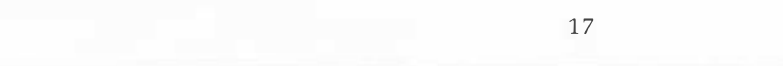
Figure 2 Culverwell mesolithic site: schematic stratigraphic section of the east-facing side of trench 41, showing the buried midden deposits (layers 7-13) and the overlying colluvial deposits (layers 1-6}.